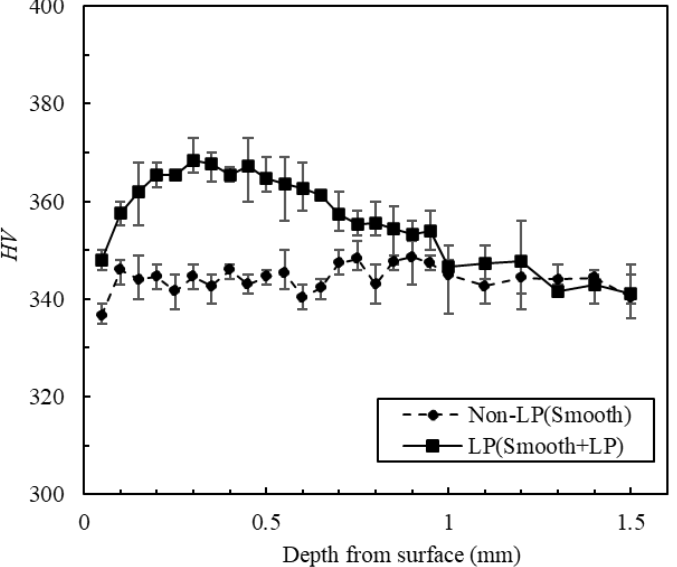
Figure 5. Distribution of the Vickers hardness at the cross-section of each specimen.